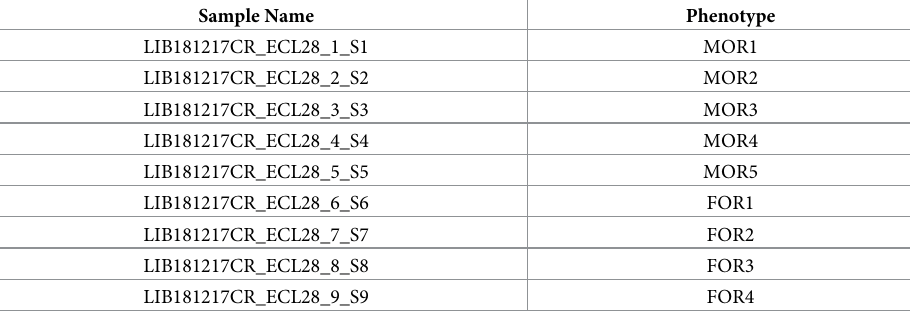
Table 2. Sample names and associated